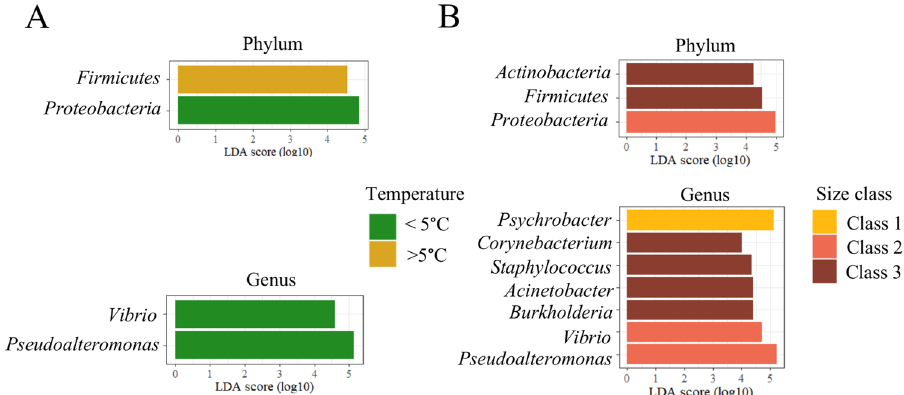
Figure 6. Discriminant taxa associated with seawater temperature and size classes. ( A ) LEfSe analysis of the blood microbiome showing the significantly different taxa in Greenland halibut ( A ) inhabiting cold (n = 25) and warm (n = 72) seawater and ( B ) according to their size class (Class 1, n = 36, Class 2, n = 22, Class 3, n = 39).